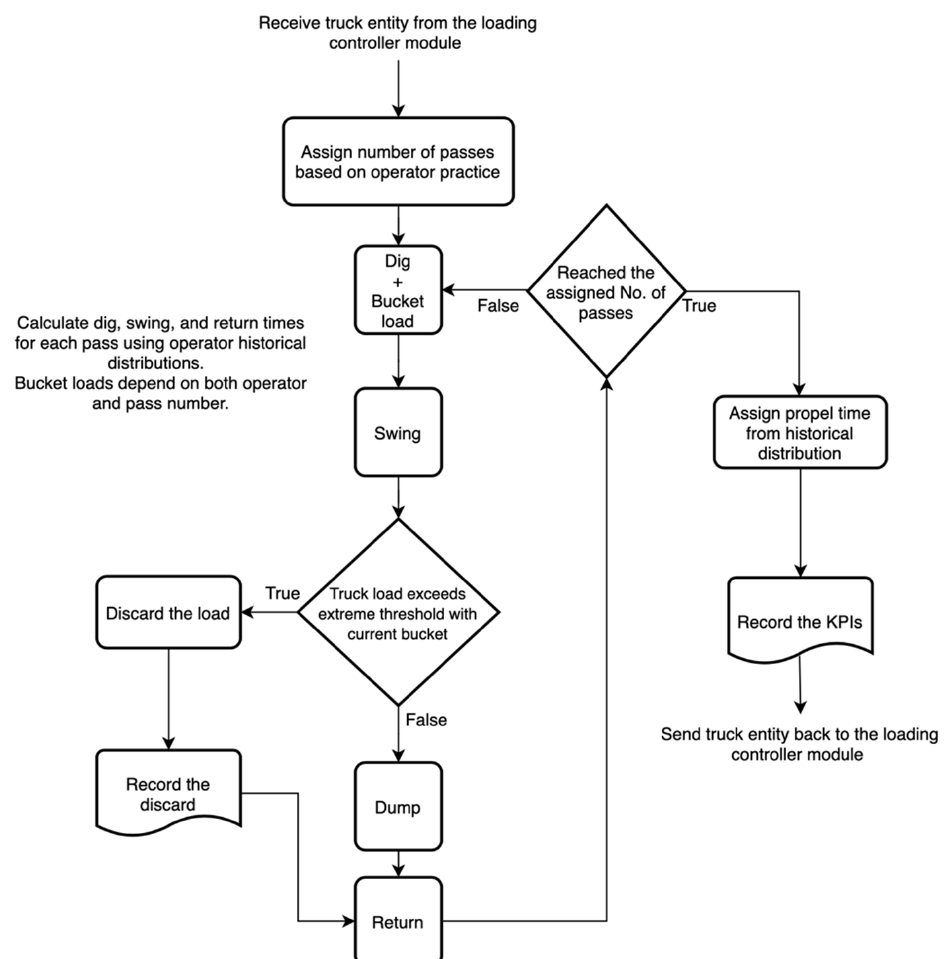
Figure 2. Electric rope shovel simulation sub-module.